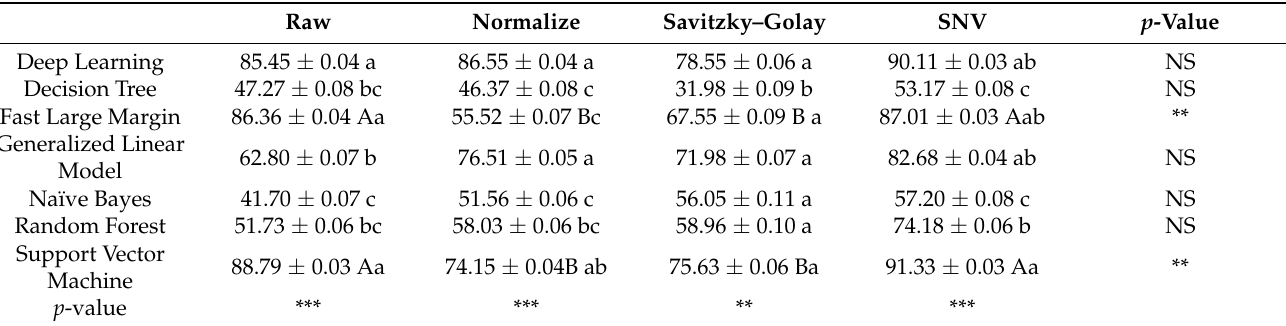
Table 2. Model precisions of different preprocessing and models for the discrimination of four B. juncea varieties.